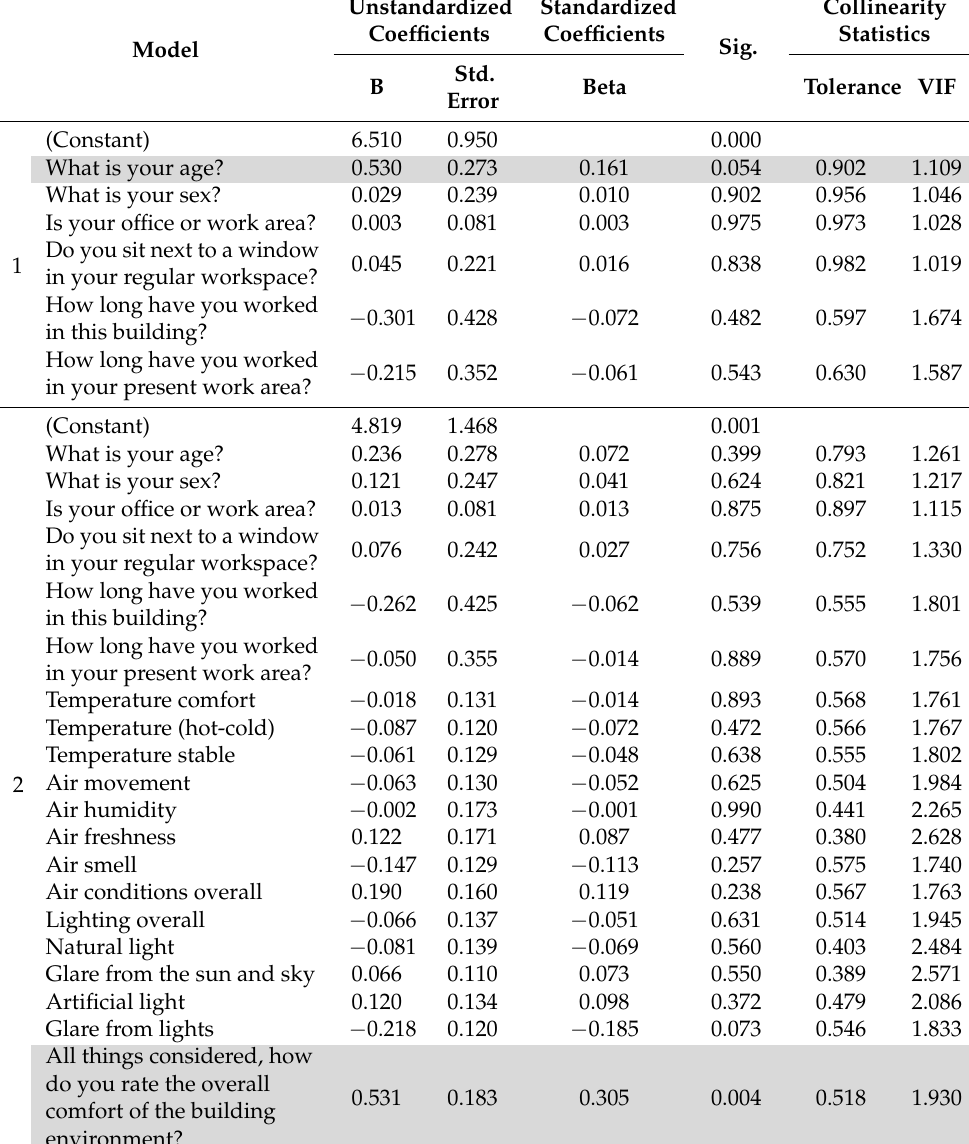
Table 7. Coefficient results of the influence of building conditions and comfort on productivity.